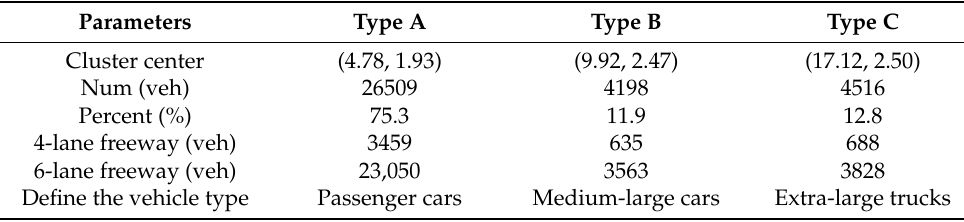
Table 3. The result of the vehicle classification.